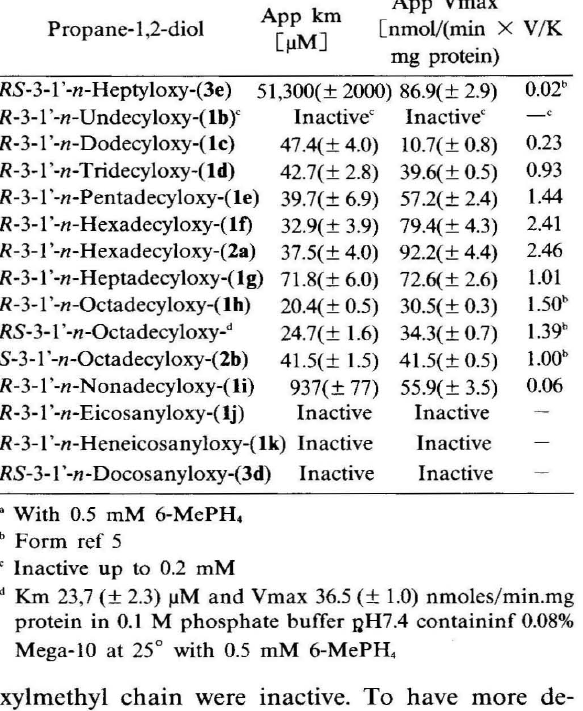
data using a computer program